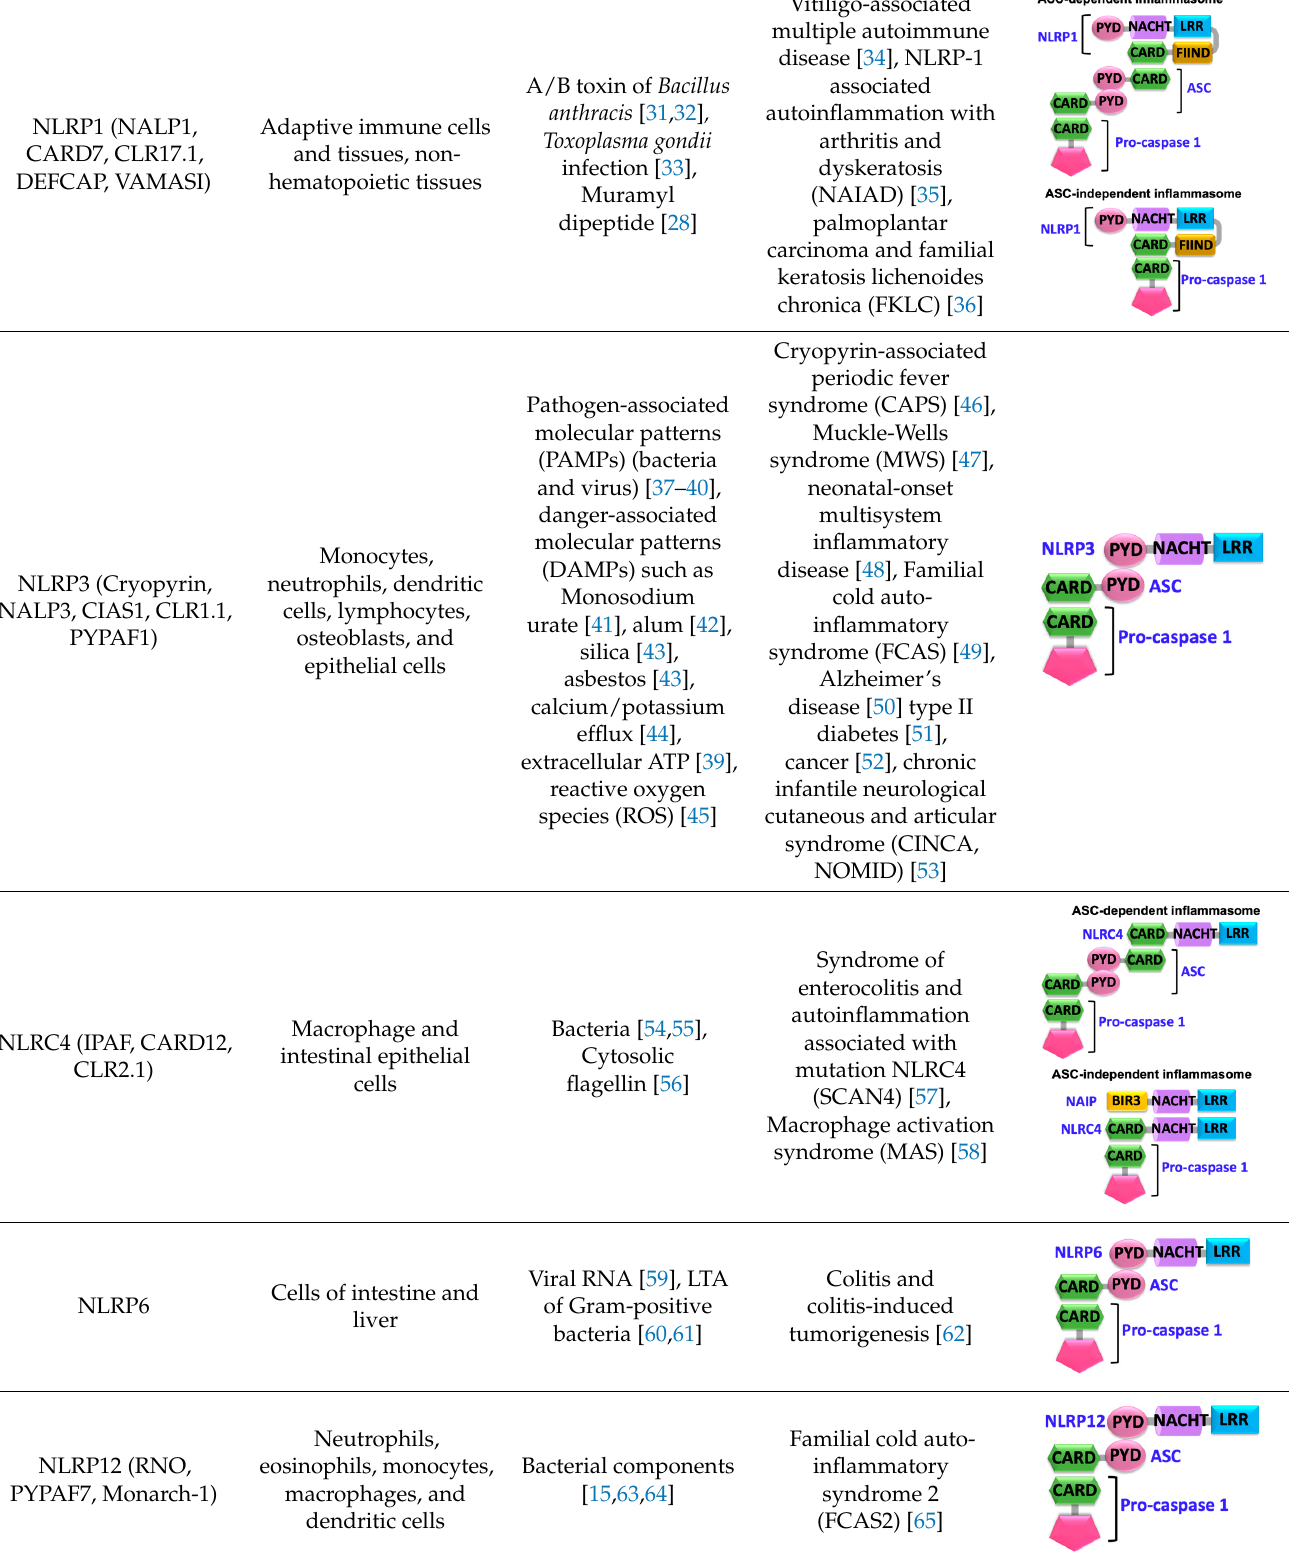
Table 1. Structural and functional details of canonical and non-canonical inflammasomes.